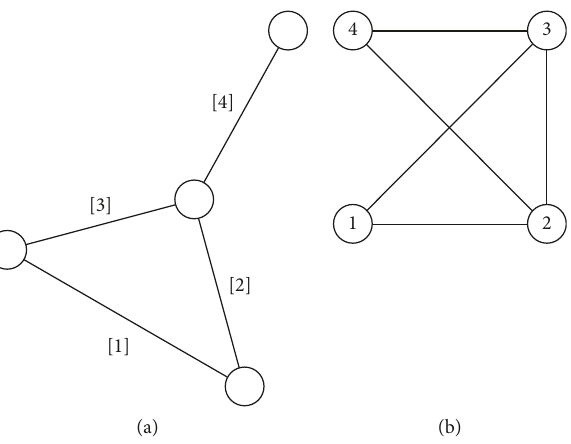
Figure 2: (a) Graph G . (b) Line graph L ( G ) of G [27].